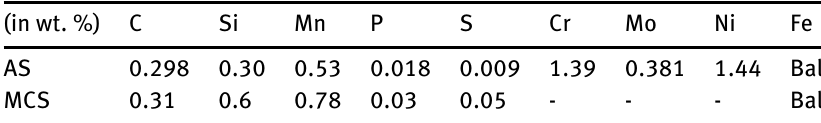
Table 1: Chemical composition of base materials.